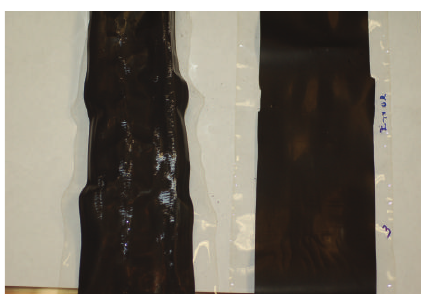
Figure 13: Photograph showing nonideal coating of Nafion (left) next to drying controlled by a model-based LQG